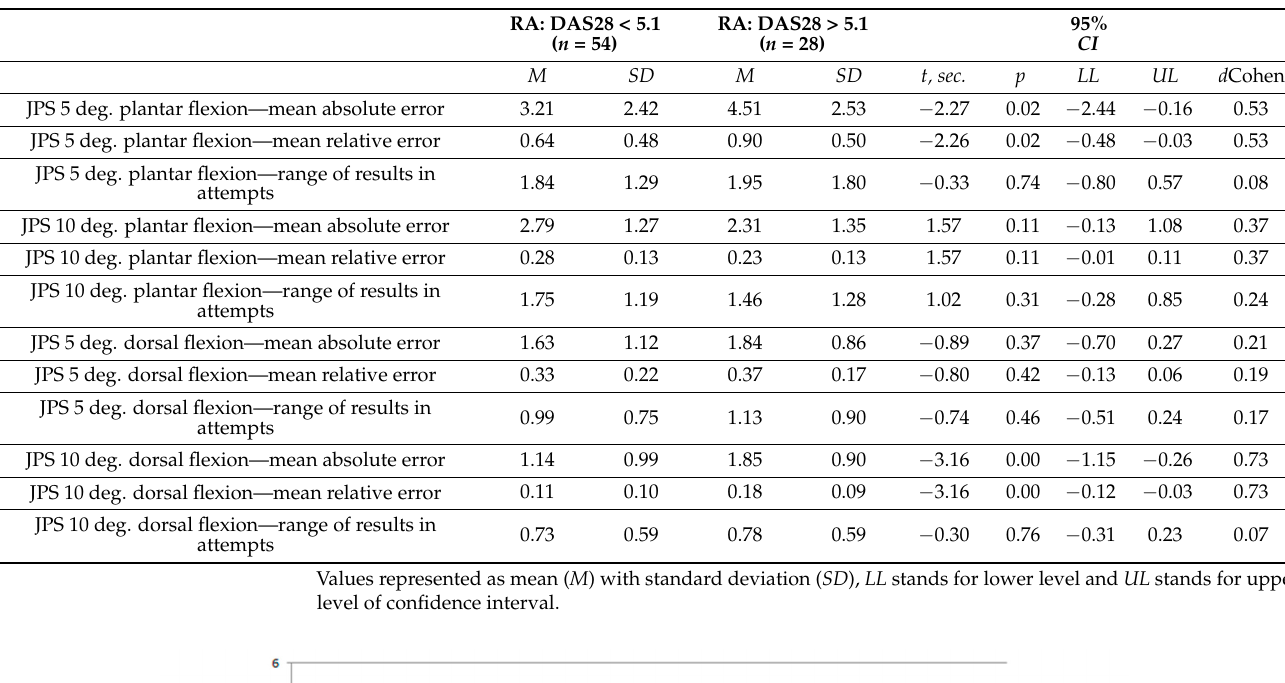
Table 4. Comparison of the results of JPS assessment between groups for both lower limbs based on the activity of the disease.